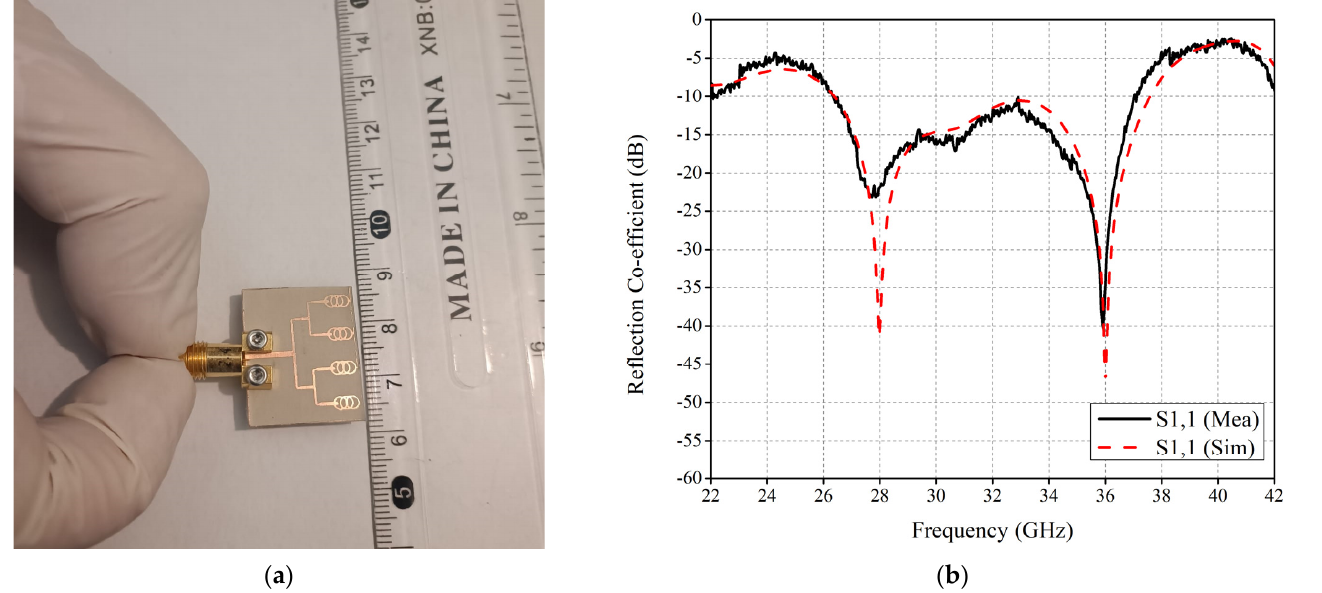
Figure 6. ( a ) Fabricated prototype ( b ) simulated and measured S-parameters.